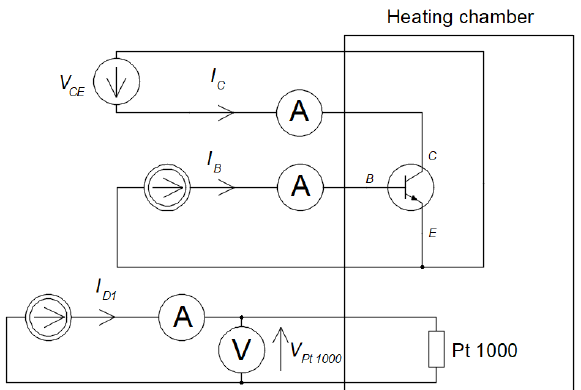
Figure 8. Electrical circuit that allows the designation of the relationship between transistor gain β and collector current I C